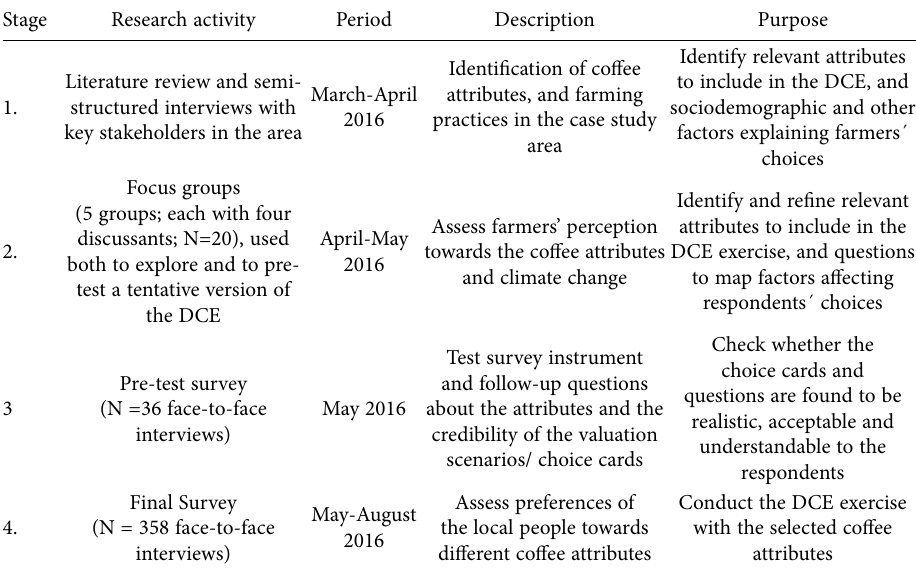
Table 1 . Description of process of developing the Discrete Choice Experiment (DCE)